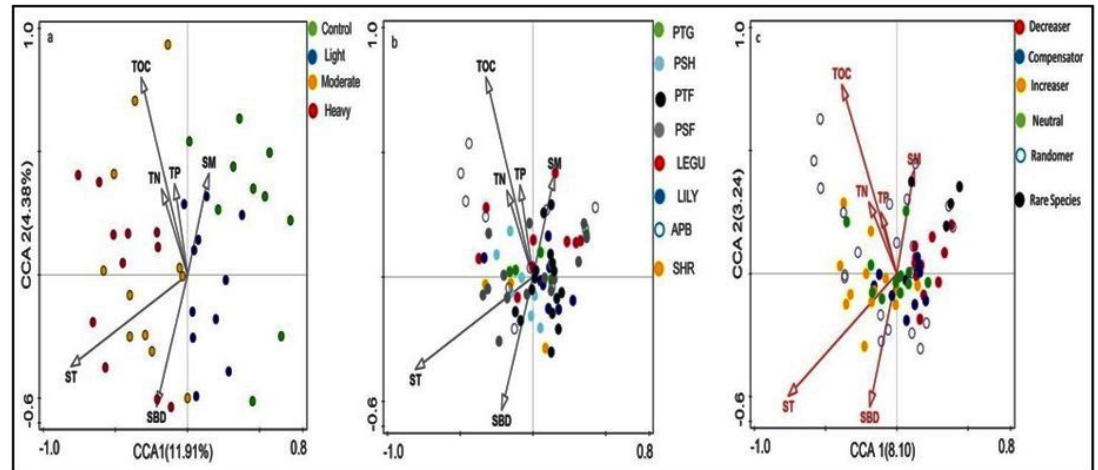
Figure 6. Relationship between plant functional groups and species change patterns in succession with soil factors. (a) Sample plots; (b , c) species plots grouped by functional group and succession change pattern of the species, respectively. Vectors shown represent the major explanatory soil factors. SBD—soil bulk density SM—soil moisture; ST—soil temperature; TOC—total organic carbon; TN—total nitrogen; TP—total phosphorus.